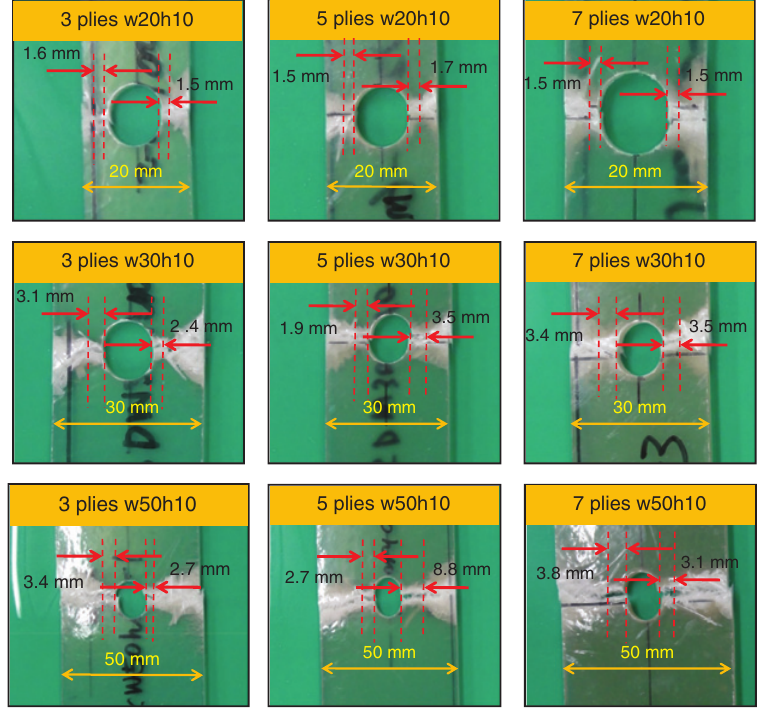
Figure 8 Measurement of parallel area length.